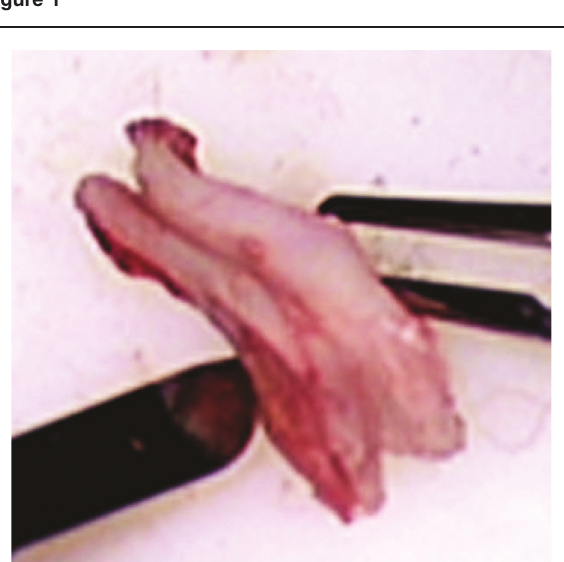
Butterfly cartilage after scoring.